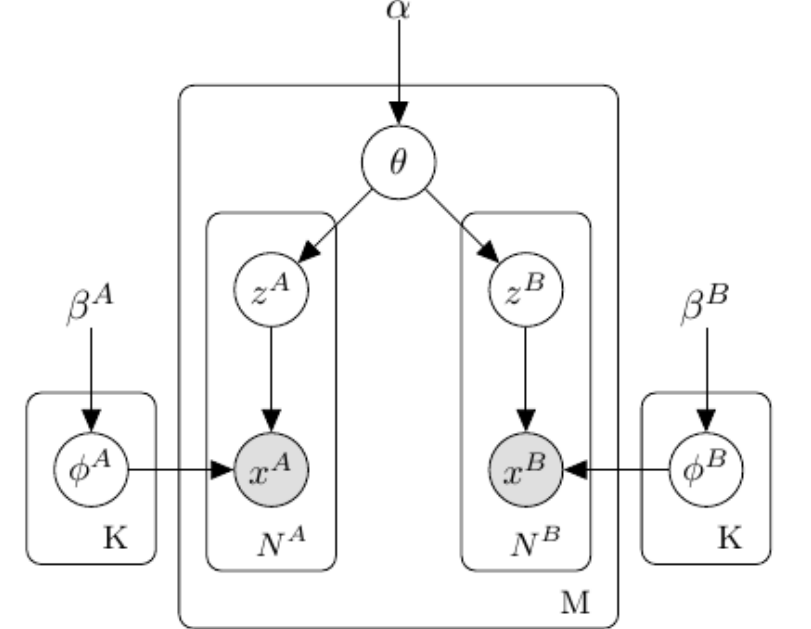
Figure 2. Graphical representation of the multiview latent Dirichlet allocation model. K: number of topics; M: number of prescriptions; N A : number of diagnoses per prescription; N B : number of medications per prescription; x A : diagnosis (type A feature); x B : medication (type B feature); z A : topic of x A ; z B : topic of x B ; φ A : topic-diagnosis distribution; φ B : topic-medication distribution; β A : hyperparameter of φ A ; β B : hyperparameter of φ B ; θ : prescription-topic distribution; α : hyperparameter of θ